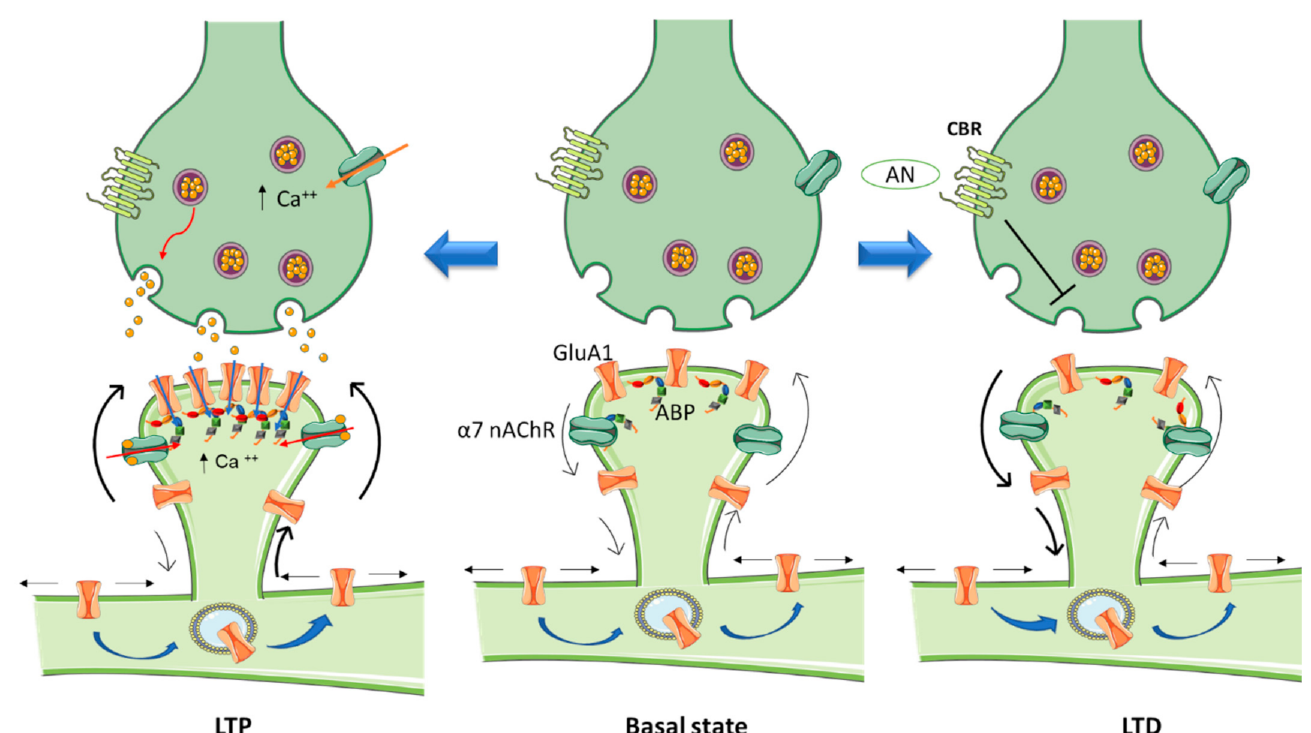
Figure 1. Schematic diagram highlighting the role of nanoscale sub-compartmentalization of the dendritic spine in synaptic plasticity. The “basal” state can be depicted as a homeostatic equilibrium between synthesis, lateral diffusion, internalization, degradation, and recycling of neurotransmitter receptors at the dendritic spine. Activation of α 7 nicotinic acetylcholine receptor ( α 7 nAChR) in the hippocampus by agonist on postsynaptic sites promotes LTP (left) by depolarizing the spine which induces glutamatergic GluA1 receptors to cluster at the PSD. This incorporation of GluA1 receptor molecules further contributes to calcium entry, thus strengthening synaptic transmission. The opposite phenomenon (LTD, right) is induced by activation of presynaptic cannabinoid receptors (CBRs): neurotransmitter release is inhibited, thereby weakening synaptic transmission, and GluA1 receptors are depopulated from the PSD. ABP: actin binding proteins; AN: